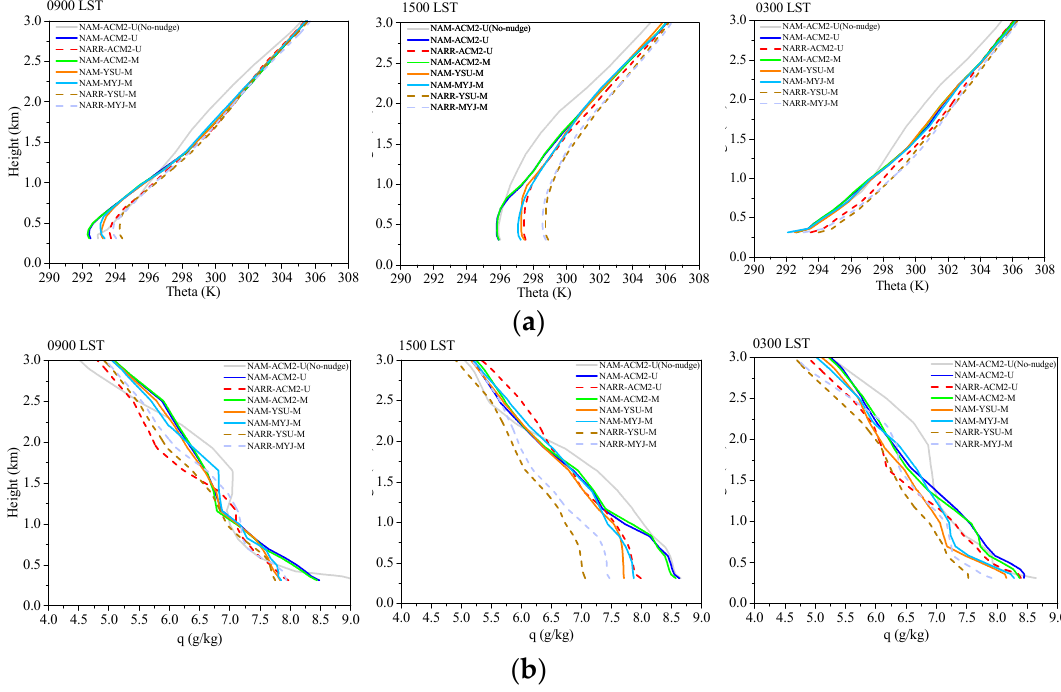
Figure 6. WRF modeled mean vertical profiles of ( a ) potential temperature (theta: K) and ( b ) water vapor mixing ratio (q: g kg − 1 ) at 0900, 1500, and 0300 LST over the observation site from 22 to 28 September.